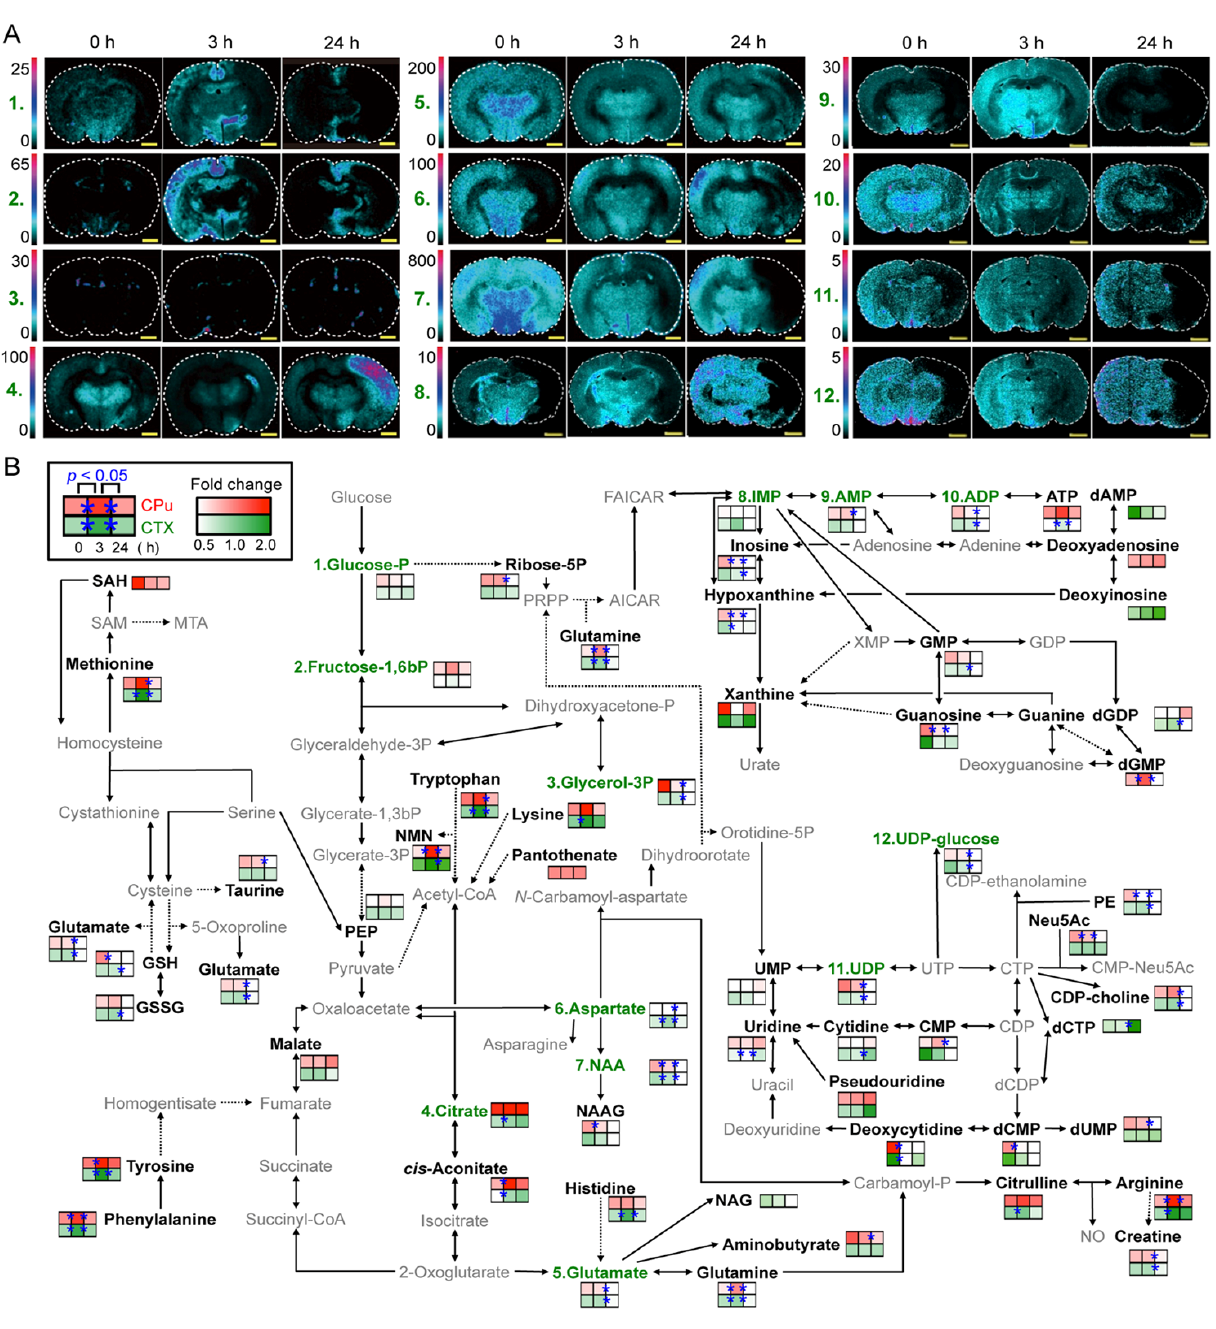
Figure 3. Integrated MSI and LC-MS techniques for visualizing spatiotemporal metabolite distribution. ( A ) In situ MSI visualized the spatiotemporal metabolic behavior in MCAO rat brain. Metabolites (nucleotide and amino acid metabolism, as well as the central pathway) were simultaneously visualized in a single MSI experiment. Scale bar (1.0 mm). ( B ) Comparative visualization of the central metabolic pathway and its peripheral pathways in the CPu ( upper box, red ) and CTX ( lower box, green ), as determined by LC-MS. Significant differences (Student’s t -test, * p <0.05) are indicated by asterisks on the colored boxes . Black and grey letters indicate LC-MS-detected metabolites and unmeasured metabolites, respectively. Green letters indicate metabolites detected by both LC-MS and MSI. Solid arrows represent a single step connecting two metabolites, and dotted arrows represent multiple steps. Adapted with permission from